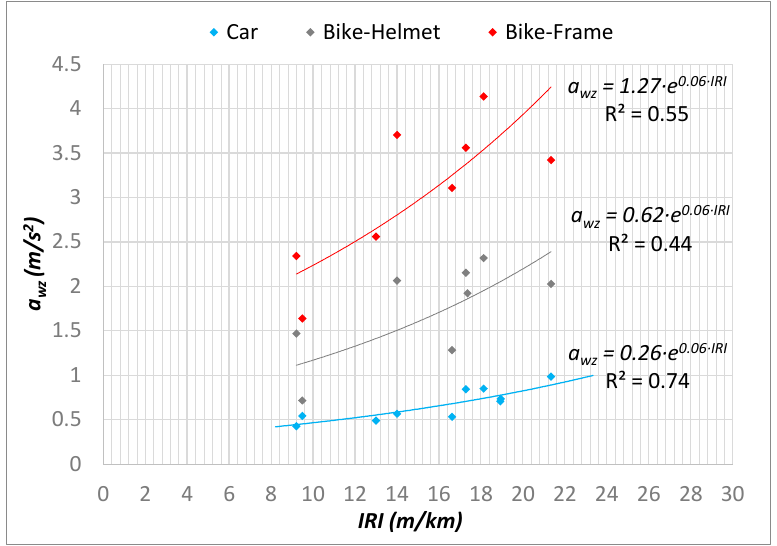
Figure 19. a wz -IRI regression considering different vehicles and sensors positions.